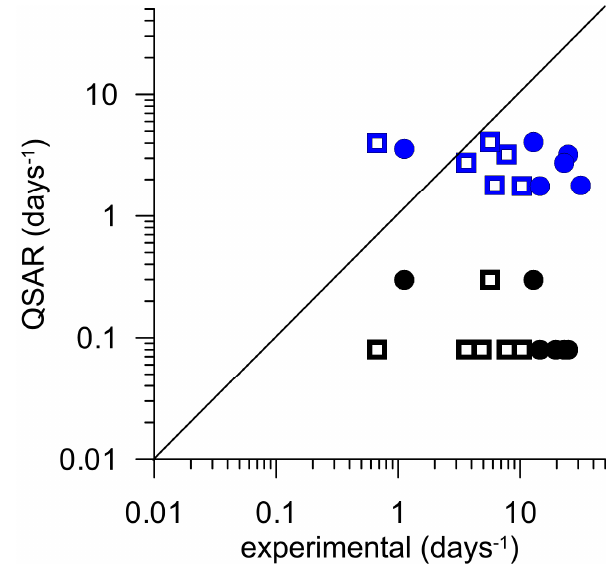
Figure 5. Comparison of data determined experimentally in core A (circles) and core B (rectangles) with data calculated according to Bertelkamp et al. ( [74] , blue) and the BIOWIN 4 model ( [73] , black).